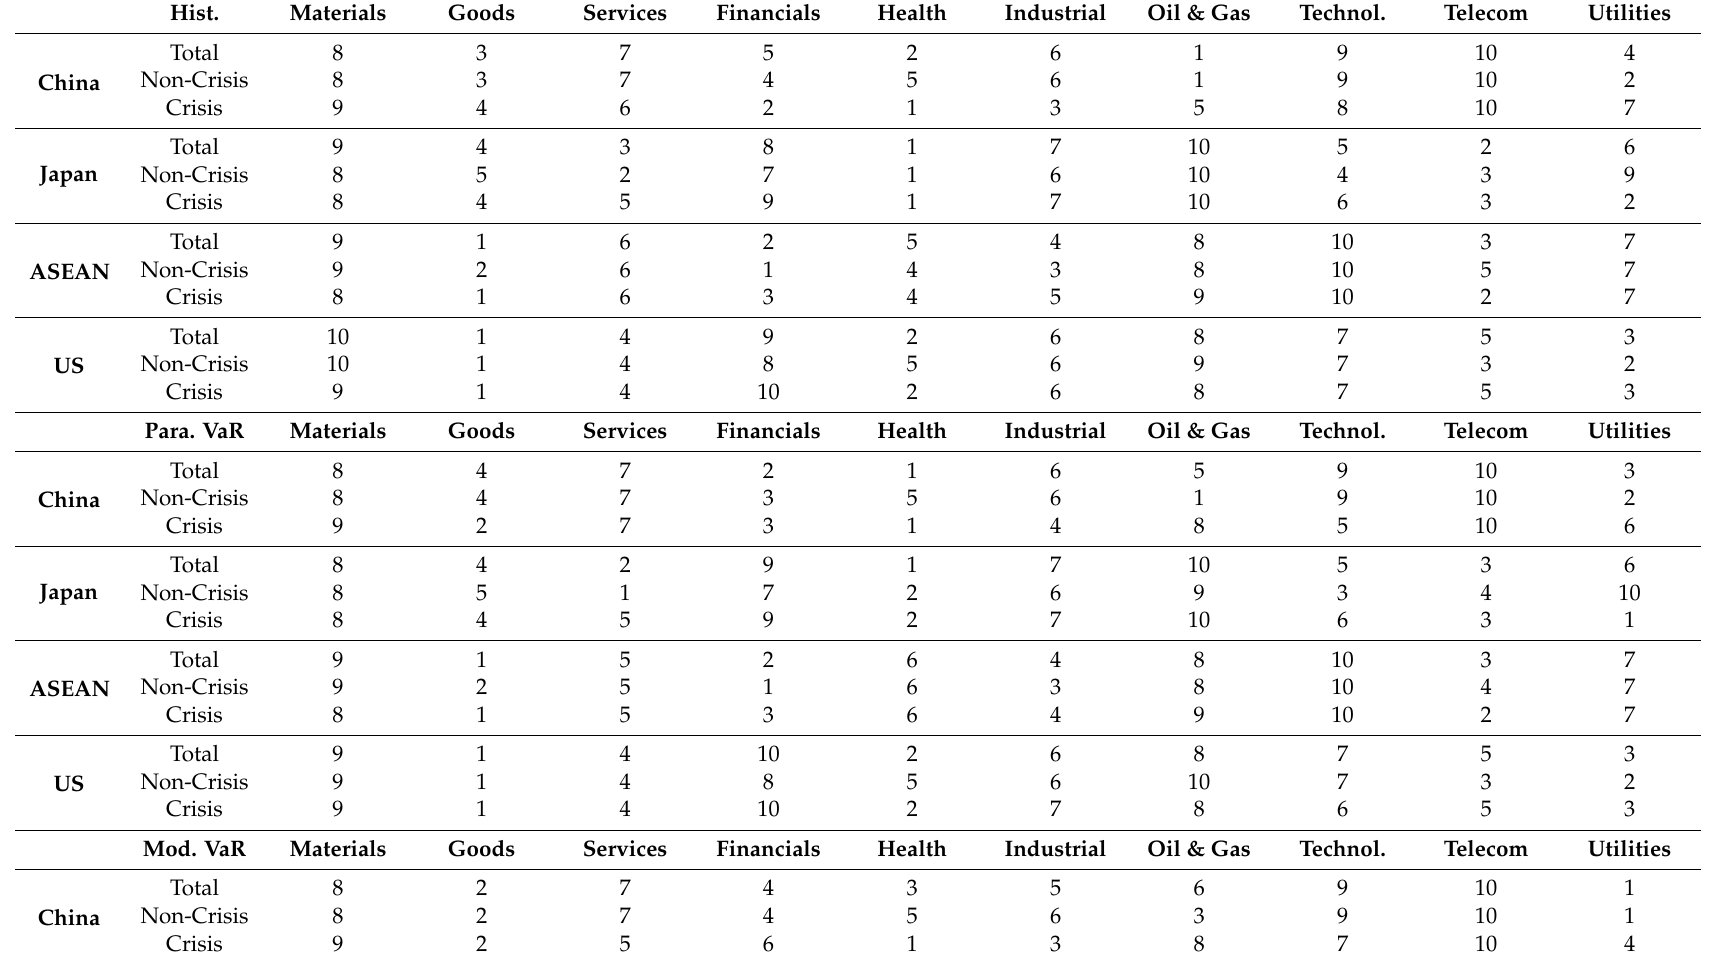
Table A3. 95% VaR and CVaR rankings per industry: